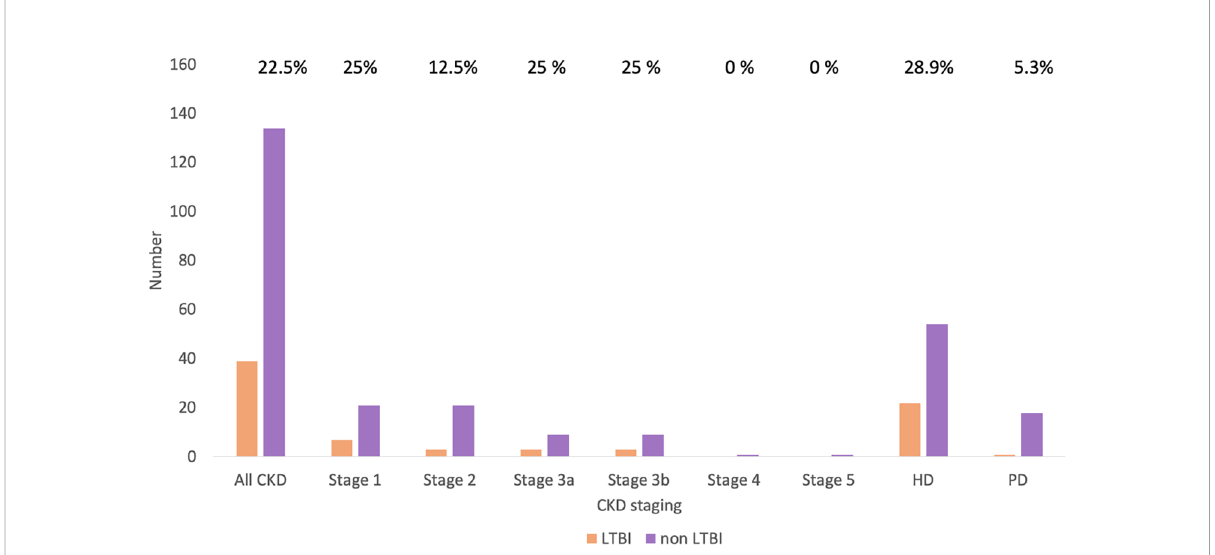
FIGURE 2 Prevalence of LTBI in patients with CKD by CKD stage. CKD, chronic kidney disease; HD, hemodialysis; LTBI, latent tuberculosis infection; PD, peritoneal dialysis.